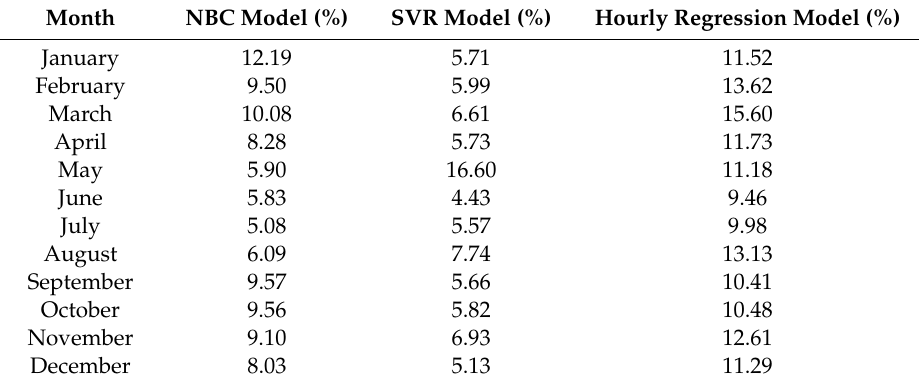
Figure 9. The NMAE for hourly regression model forecasting result in 2016. Table 1. The NMAE for each model of forecasting in 2016.